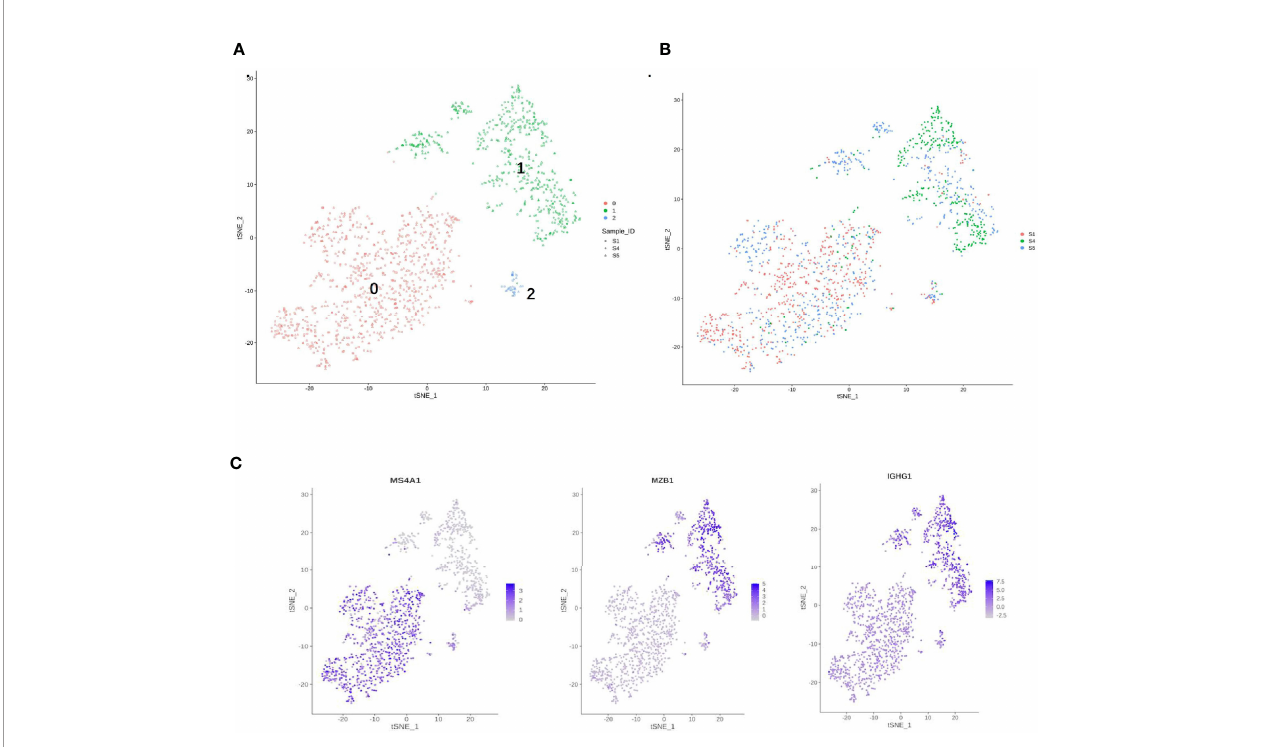
FIGURE 7 | Single-cell RNA sequencing (scRNA) pro fi les for B-cell lineages. (A) Reclustering of 1,480 B cells, color-coded by their cluster. (B) Its sample origin. (C) t -SNE plot color-coded for marker gene expression (gray to white to blue) for MS4A1 (cluster 0), MZB1, and IGHG1 (cluster